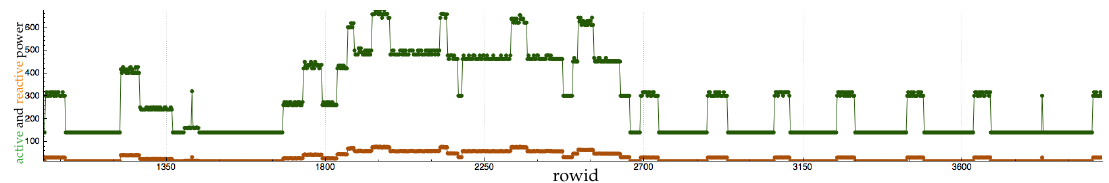
Figure 20. Evolution of electricity consumption in phase 1 during the cooking activity.